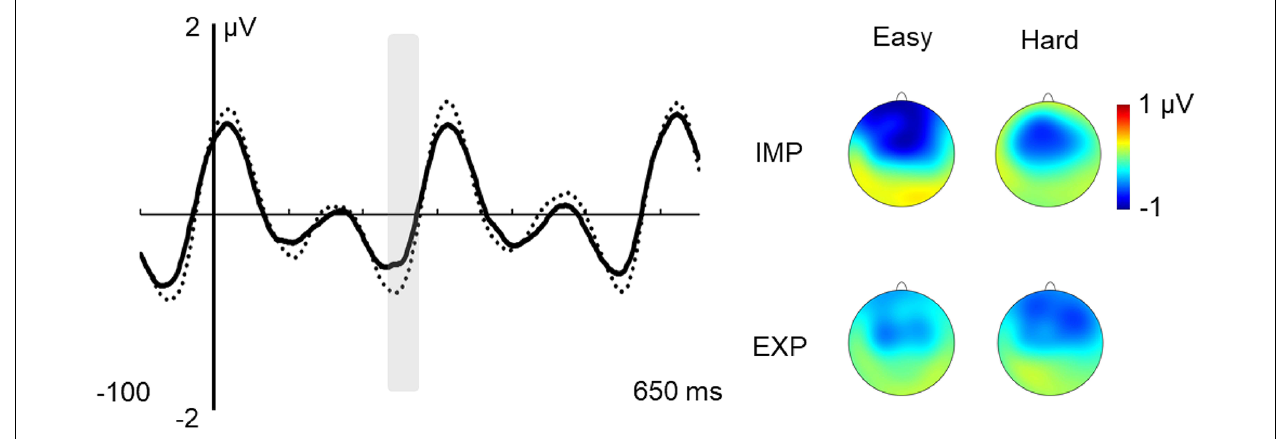
FIGURE 4 | Effect of instructions on the N250 response. Note: grand average ERPs at the fronto-central region of interest (ROI; solid line: explicit; dotted line: implicit). Gray shaded box over the ERPs indicates the analyzed time window (230–270 ms). Voltage maps of each condition: fronto-central distribution of the N250 peak.